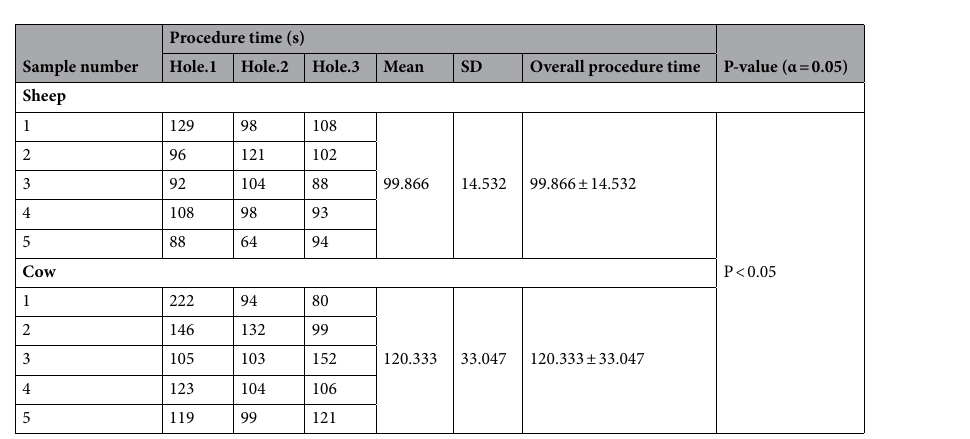
Table 1. The procedure times for each interlocking of IMN hole in sheep and cow samples.